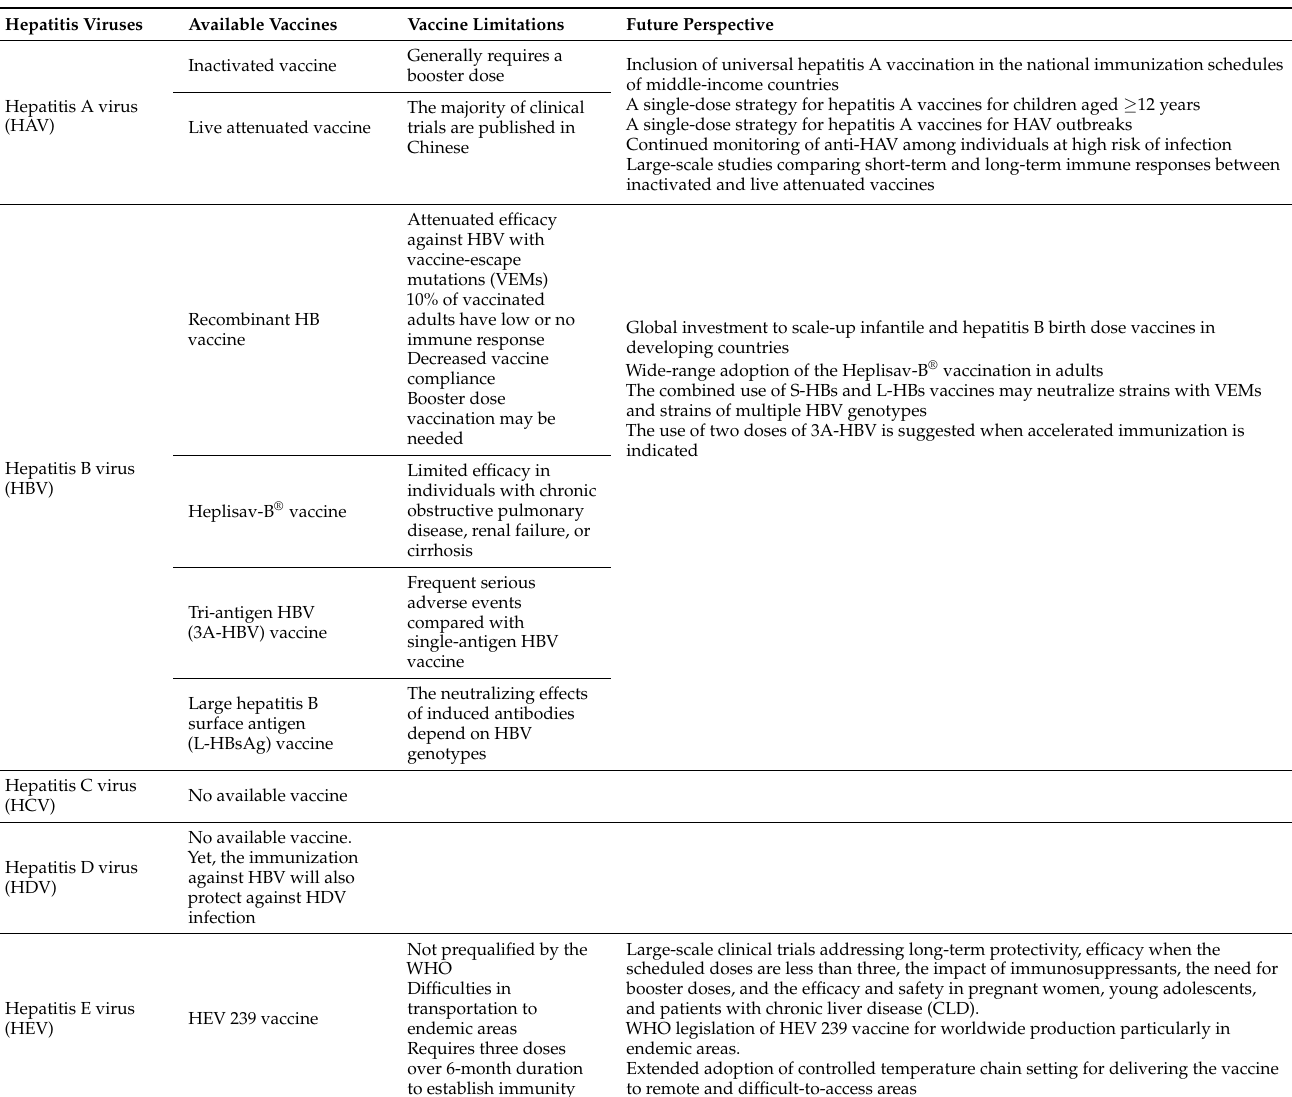
Table 2. Limitations and recommendations for the protective vaccines against viral